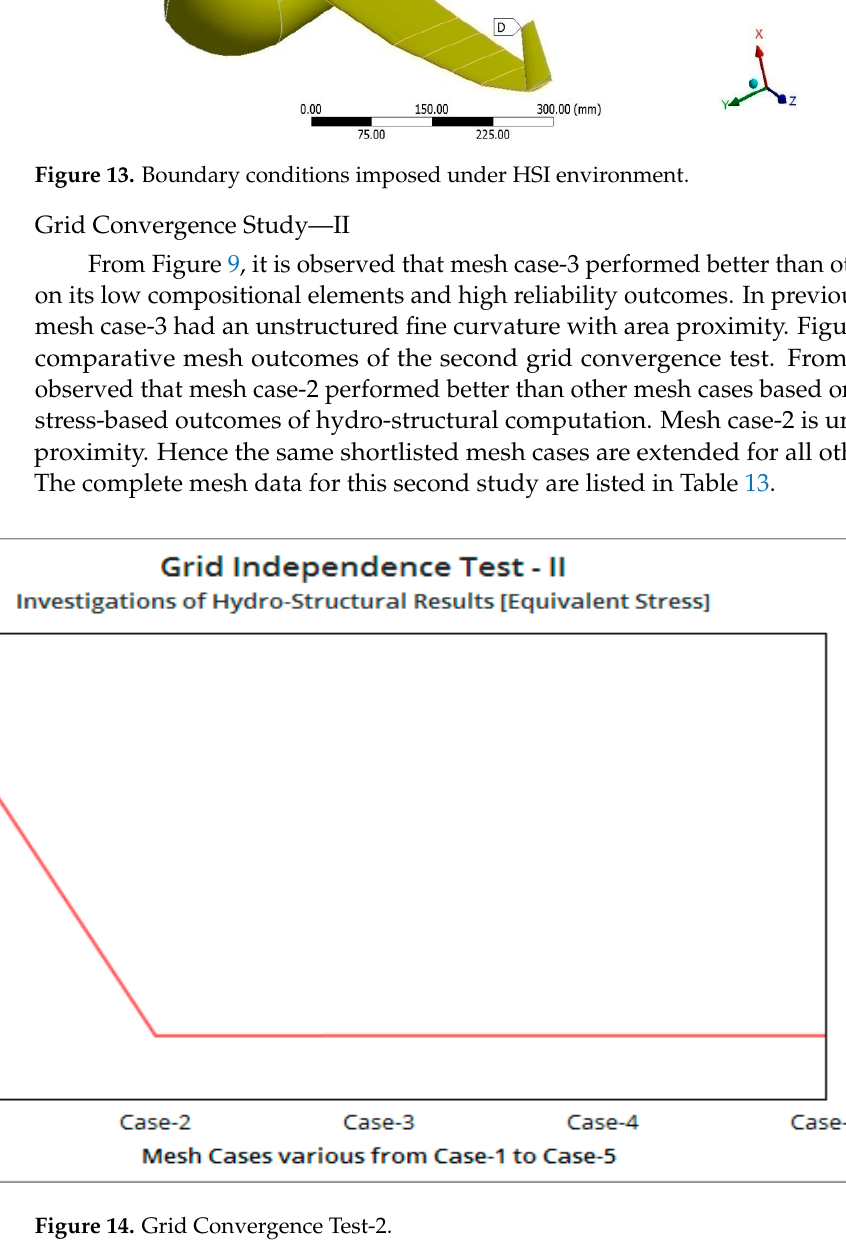
Figure 13. Boundary conditions imposed under HSI environment.